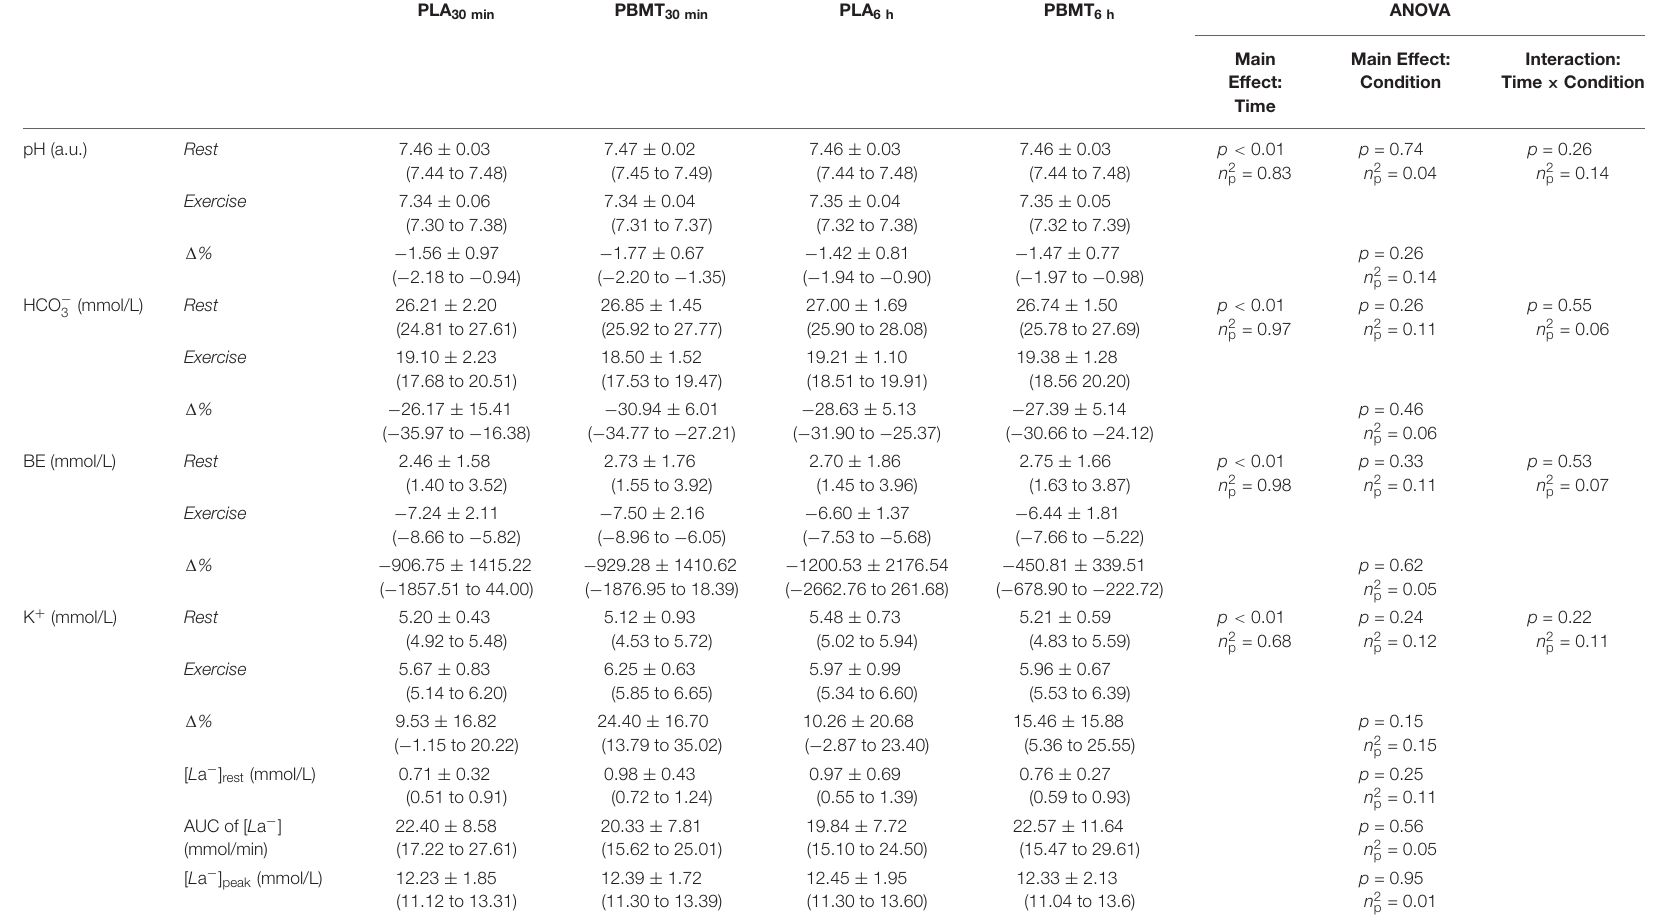
TABLE 2 | Blood metabolic indicators at rest and during severe-intensity